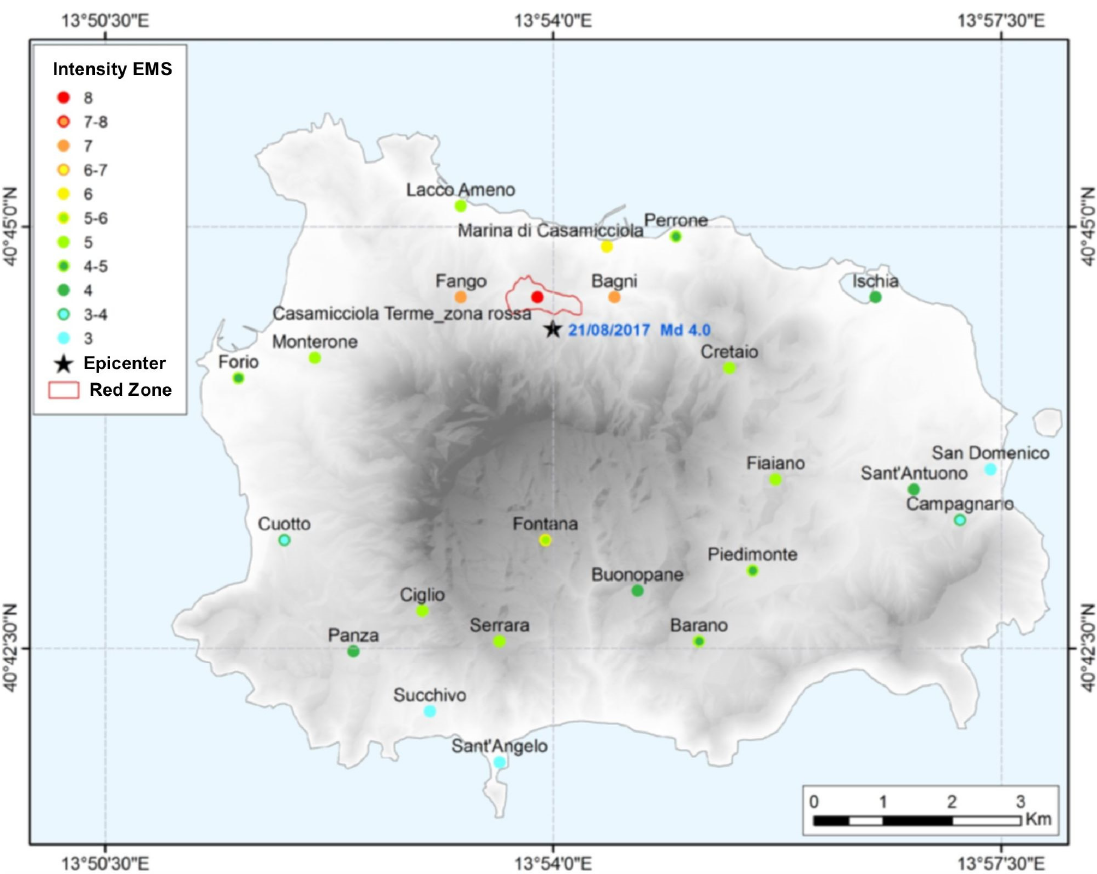
Figure 6. EMS scale intensity map of the 21 August 2017, earthquake [6]; compare with Figure 5 and note that the ESI 2007 isoseismals are concentrated in the “zona rossa” (the “red zone” with heavy damage) and nearby area along the base of Mt. Epomeo N slope; no environmental effect has been reported in the rest of the Ischia Island.